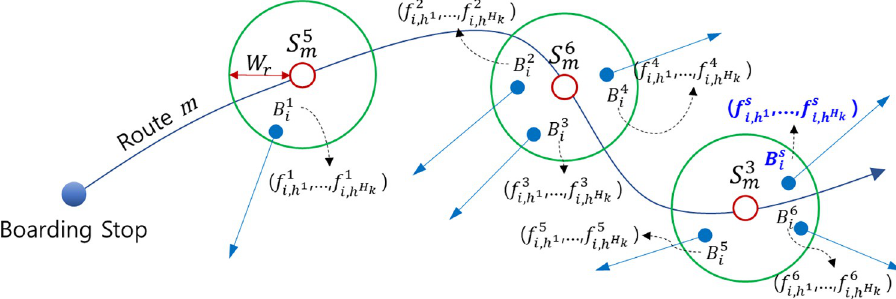
Fig 7. Concept of generating the historical trip records using the travel pattern as references. Note: f s historical boarding frequency at stop B s